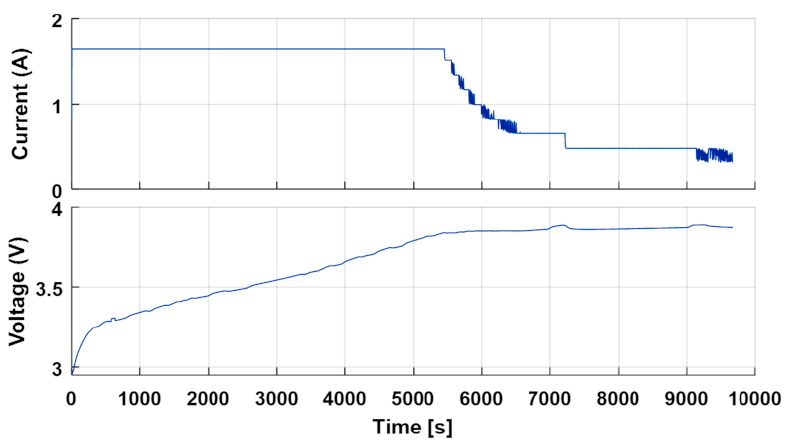
Figure 14. Samples of constant load profile and the voltage used for model